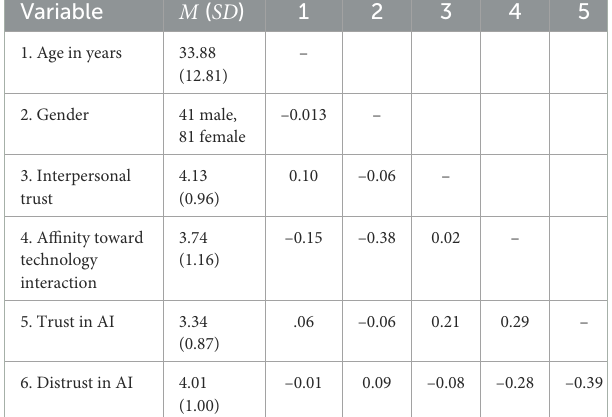
TABLE 1 Descriptive statistics and correlations of the (explanatory) user factors in the sample of 122 participants.